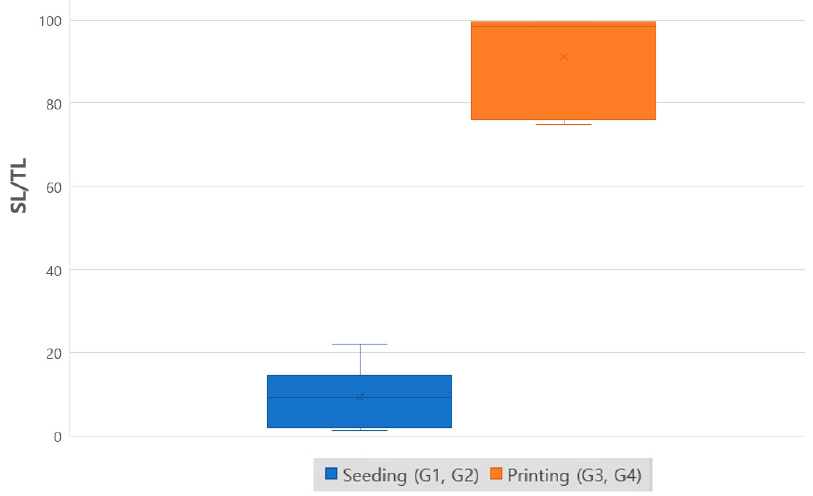
Figure 7. Comparison of SL/TL. The ratio of the total length of each sample (TL) and length of the portion in contact with the periodontal ligament-like soft tissue (SL) by histological analysis of undecalcified in vivo sample. ( p <